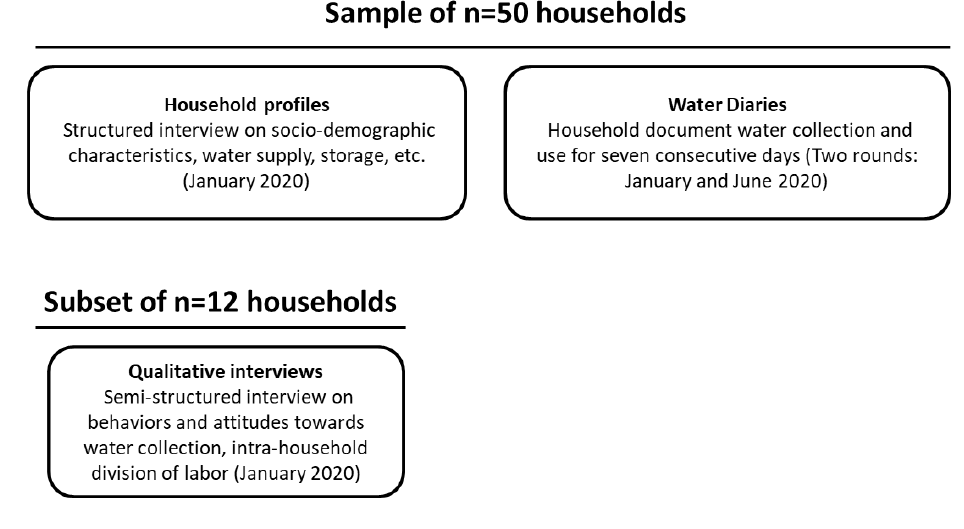
Figure 2. Overview of data collection. The household profile and water diary data are available in [41].